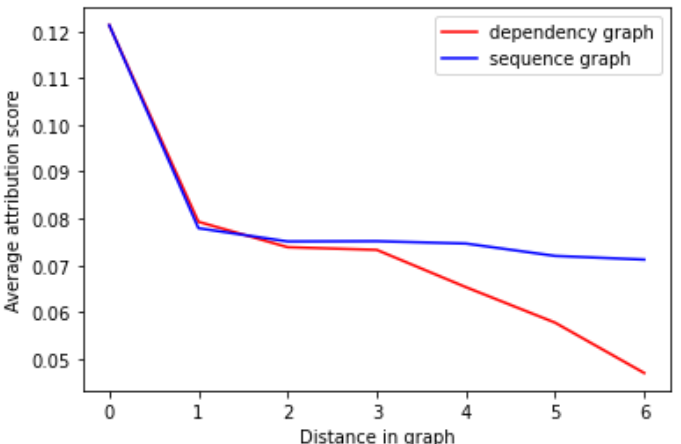
Figure 4. Average attribution score against the distance within the dependency and sequence